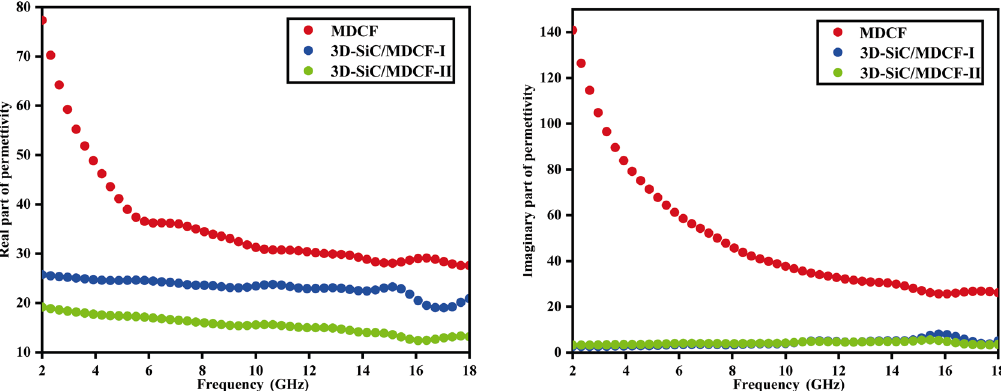
Fig. 5 Real part (a) and imaginary part (b) of the permittivity of MDCF, 3D-SiC/MDCF-I, and 3D-SiC/